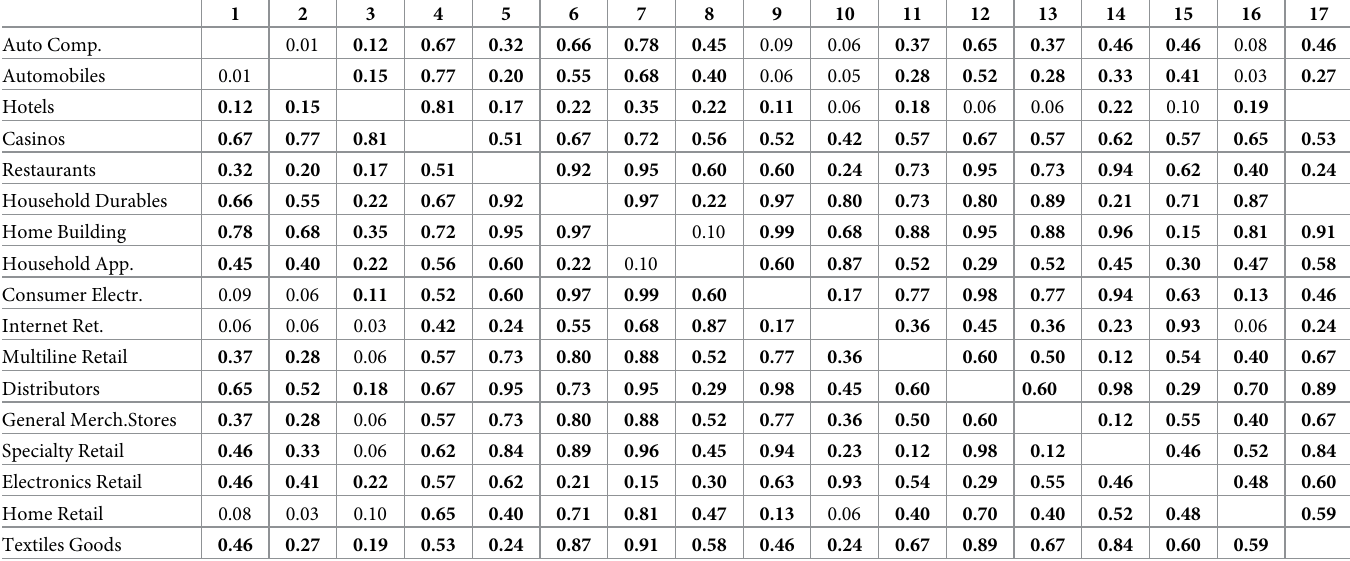
Table 9. Consumer discretionary industry.